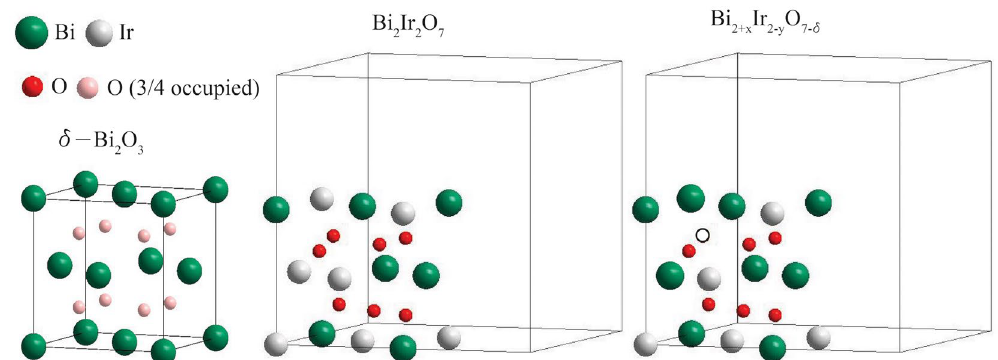
Figure 4. A unit cell of cubic δ –Bi 2 O 3 , 1/8 unit cell of Bi 2 Ir 2 O 7 and Bi 2 + x Ir 2 − y O 7 −δ . In the Bi 2 + x Ir 2 − y O 7 −δ shown above (as an example), two Ir atoms are replaced by Bi atoms and one oxygen atom is missing (represented by the open